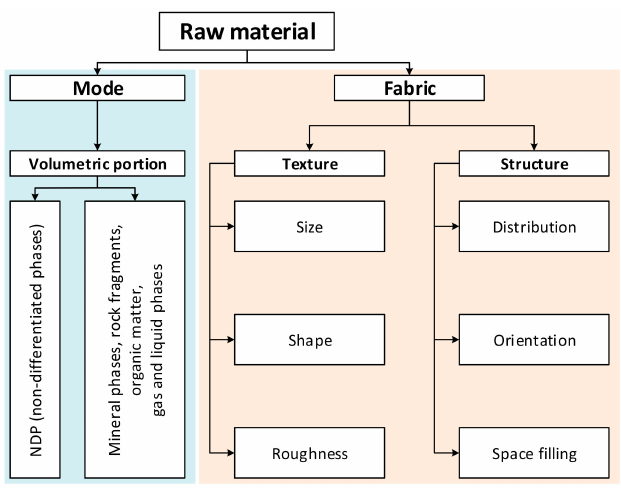
Figure 3. Characterization of raw